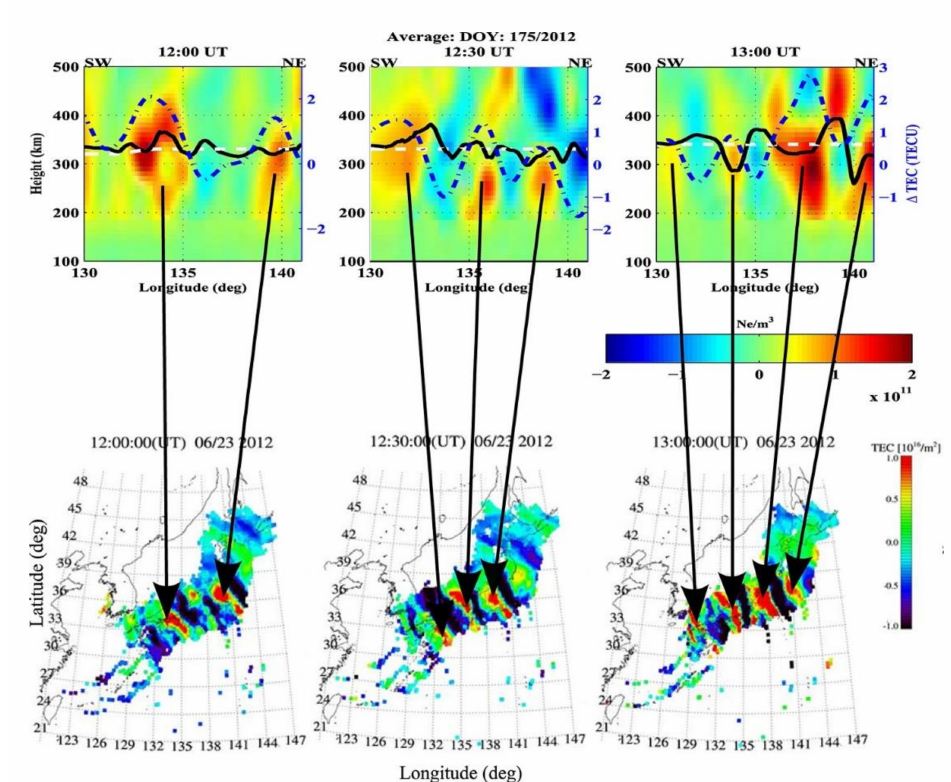
Figure 13. Comparison between longitude-altitude images of IED and horizontal total electron content (TEC) perturbation images (from [87]). The white dashed, black, and blue dashed lines indicate the variation of the peak height obtained from IRI, reconstruction IED, and TEC perturbations, respectively. The black arrows indicate the good correlation existing between the enhancements observed in the tomographic images and the TEC perturbation